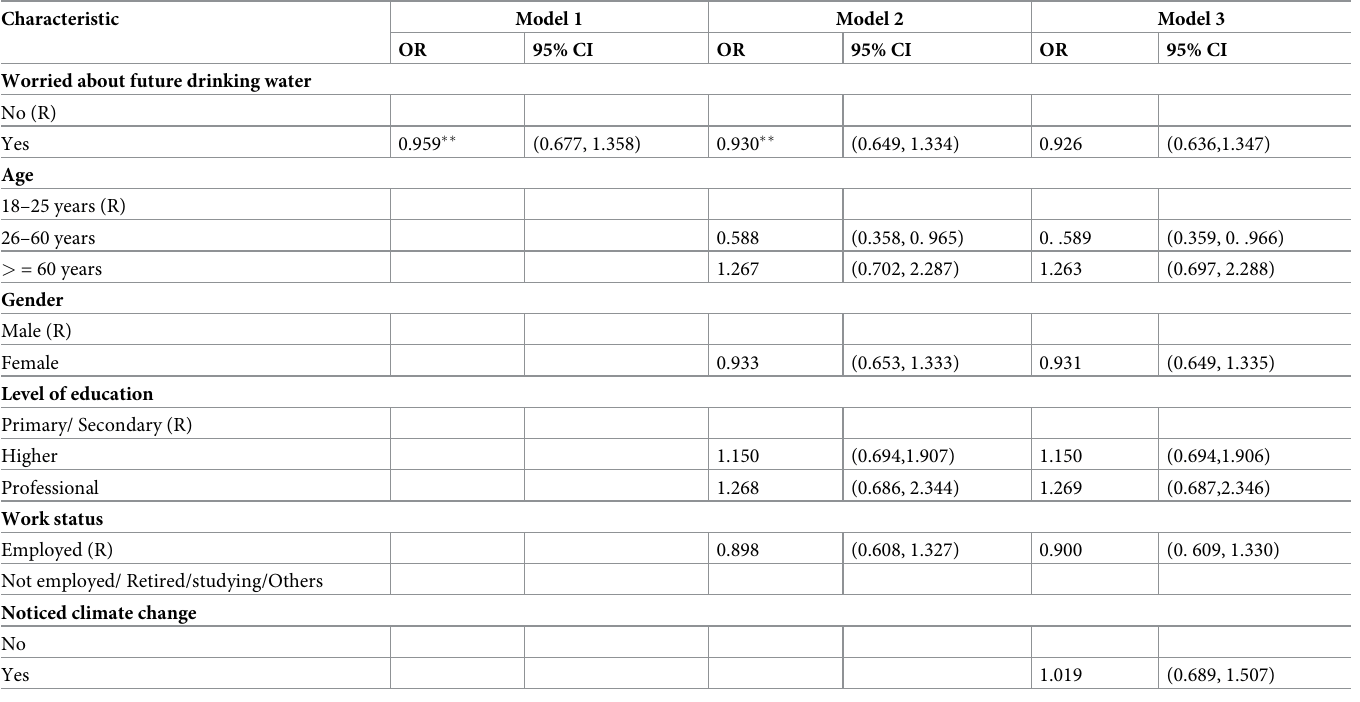
Table 4. Logistic regression results showing odds ratios (OR) and their 95% confidence intervals (CI) predicting support to